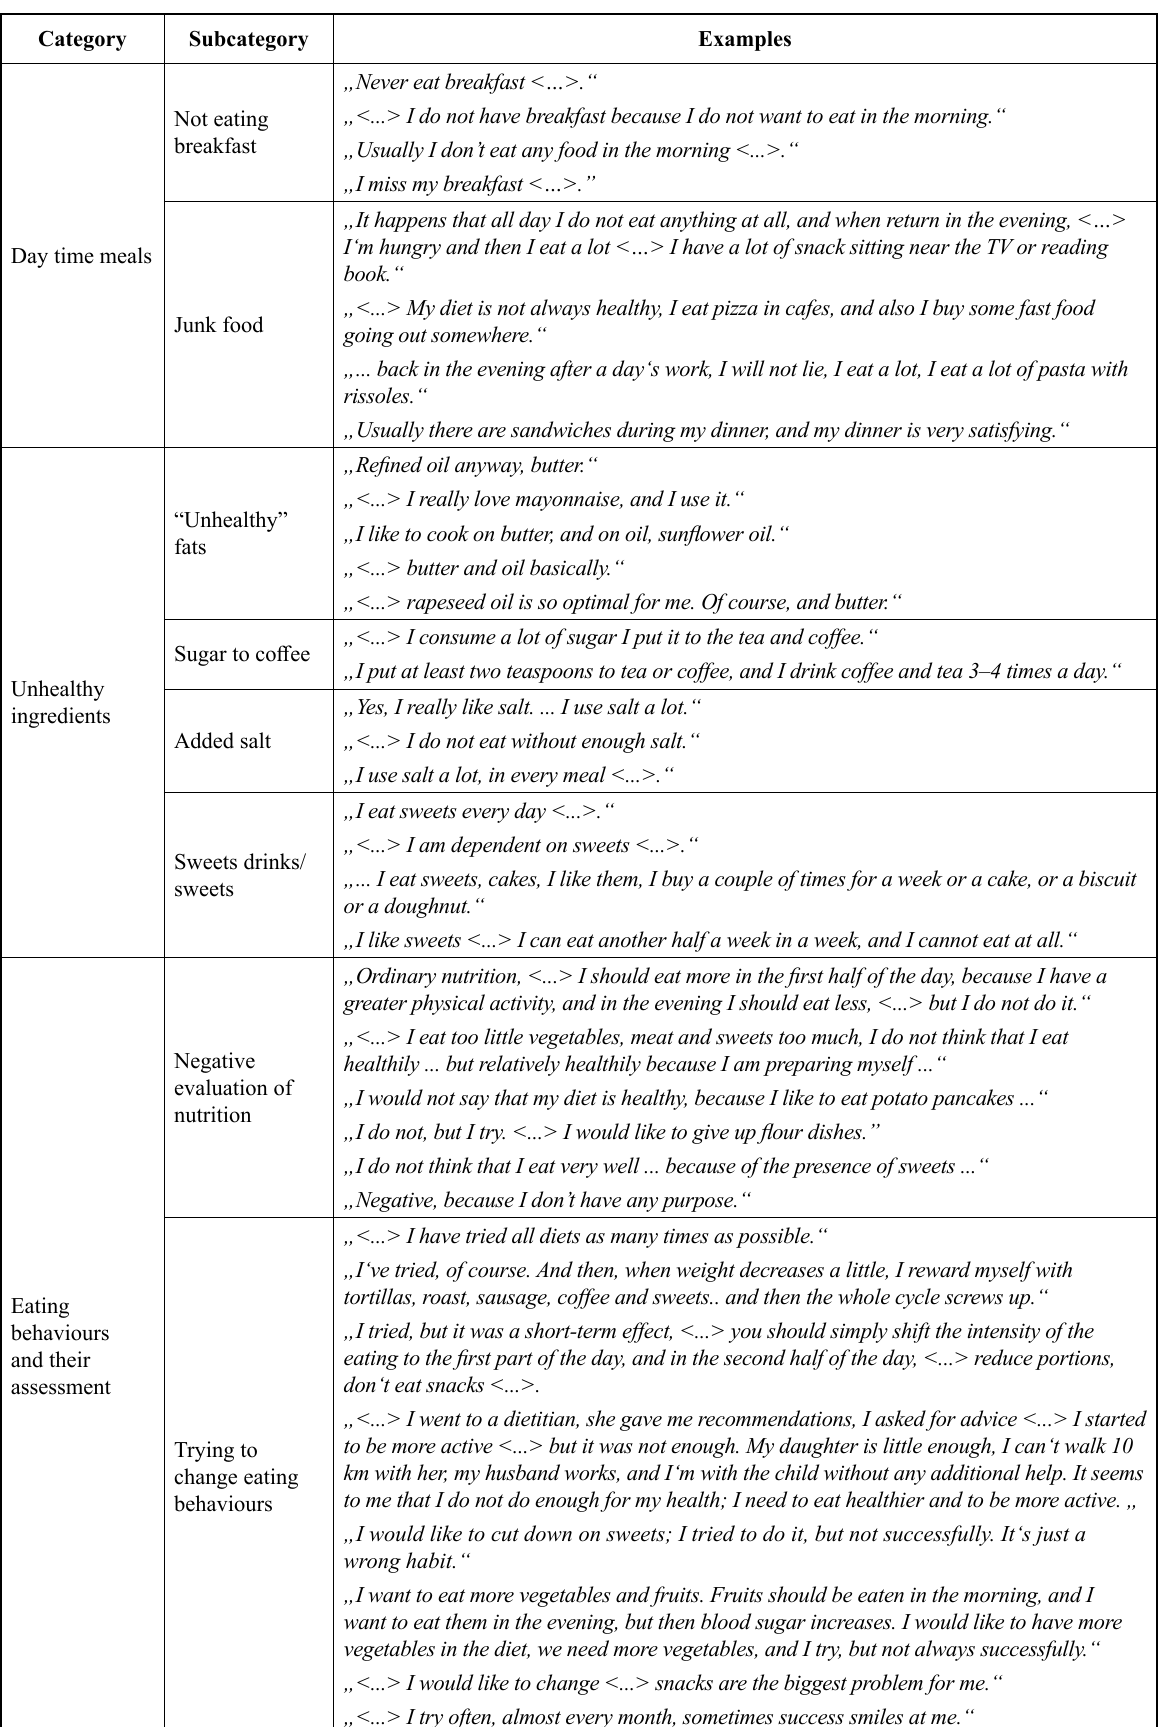
Table 3. Obesity and